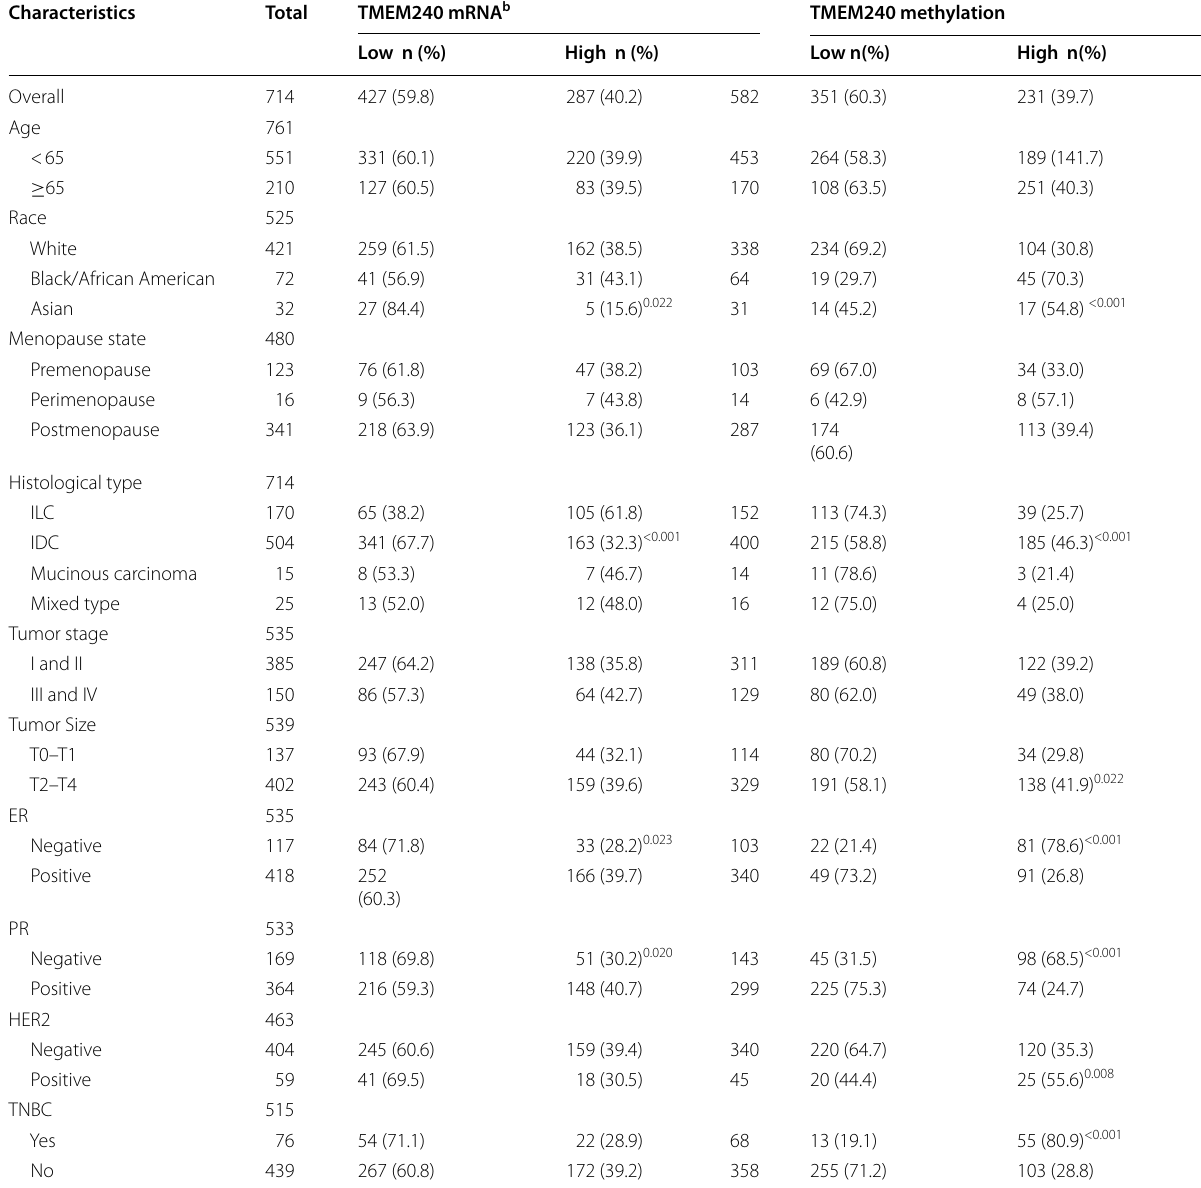
Table 2 TMEM240 mRNA expression and promoter hypermethylation in relation to the clinical parameters of breast cancer from TCGA